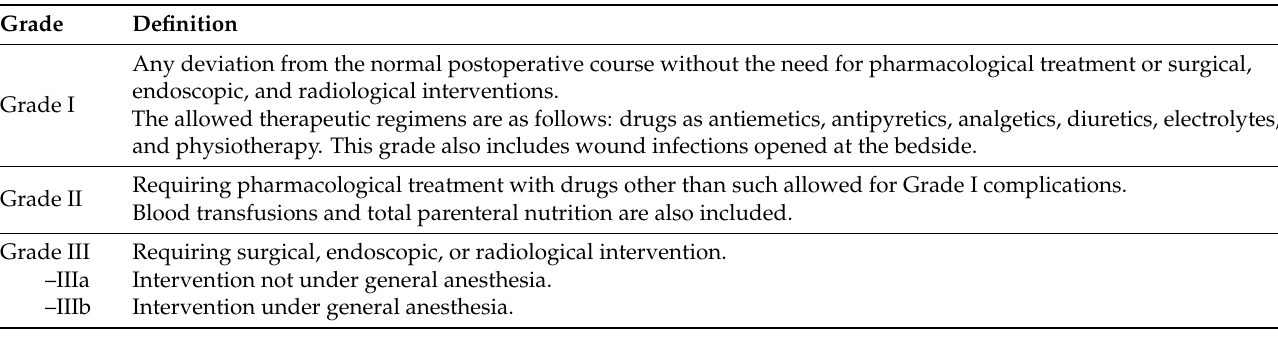
Table 1. Clavien–Dindo classification of surgical